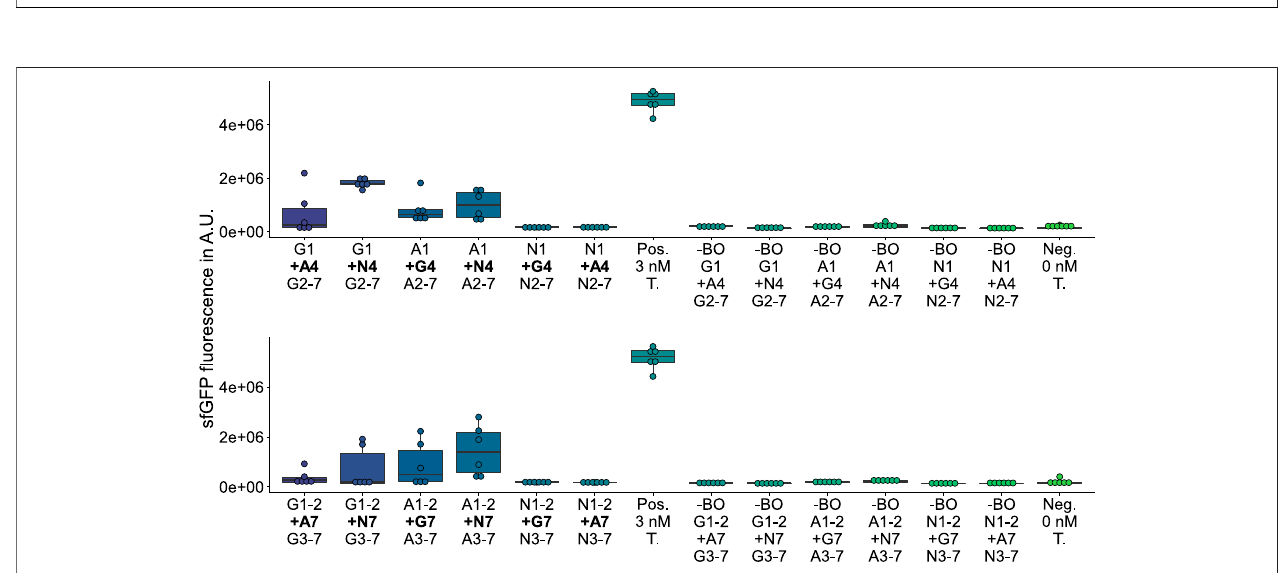
FIGURE 4 | GFP measurements of assemblies with additional sequences inserted. Top: Insertion of an additional fragment 4 between fragment 1 and 2. Bottom: Insertion of an additional fragment 7 between fragment 2 and 3. G n : sfGFP fragment n ; A n : mAvicFP1 fragment n ; N n : mNeonGreen fragment n ; Pos.: 3 nM of the template plasmid used to obtain the vector for assembly; -BO: no bridging oligos added; Neg.: No Template DNA added.